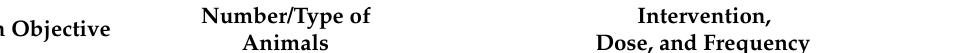
Table 3. Characteristics of the studies on animals and their